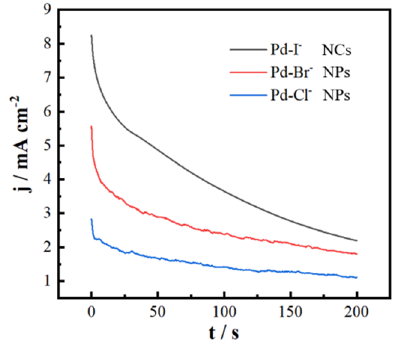
Figure 5. j - t curves of Pd nanocubes, Pd-Br − NPs, and Pd-Cl − NPs recorded in 0.25 M HCOOH + 0.25 M HClO 4 at 0.1 V for 200 s.